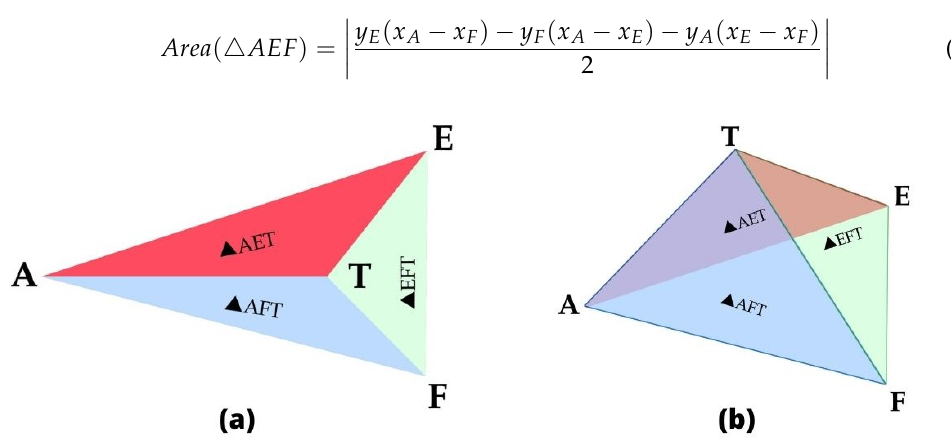
Figure 4. Random node T ( a ) lies inside the region; and ( b ) lies outside the